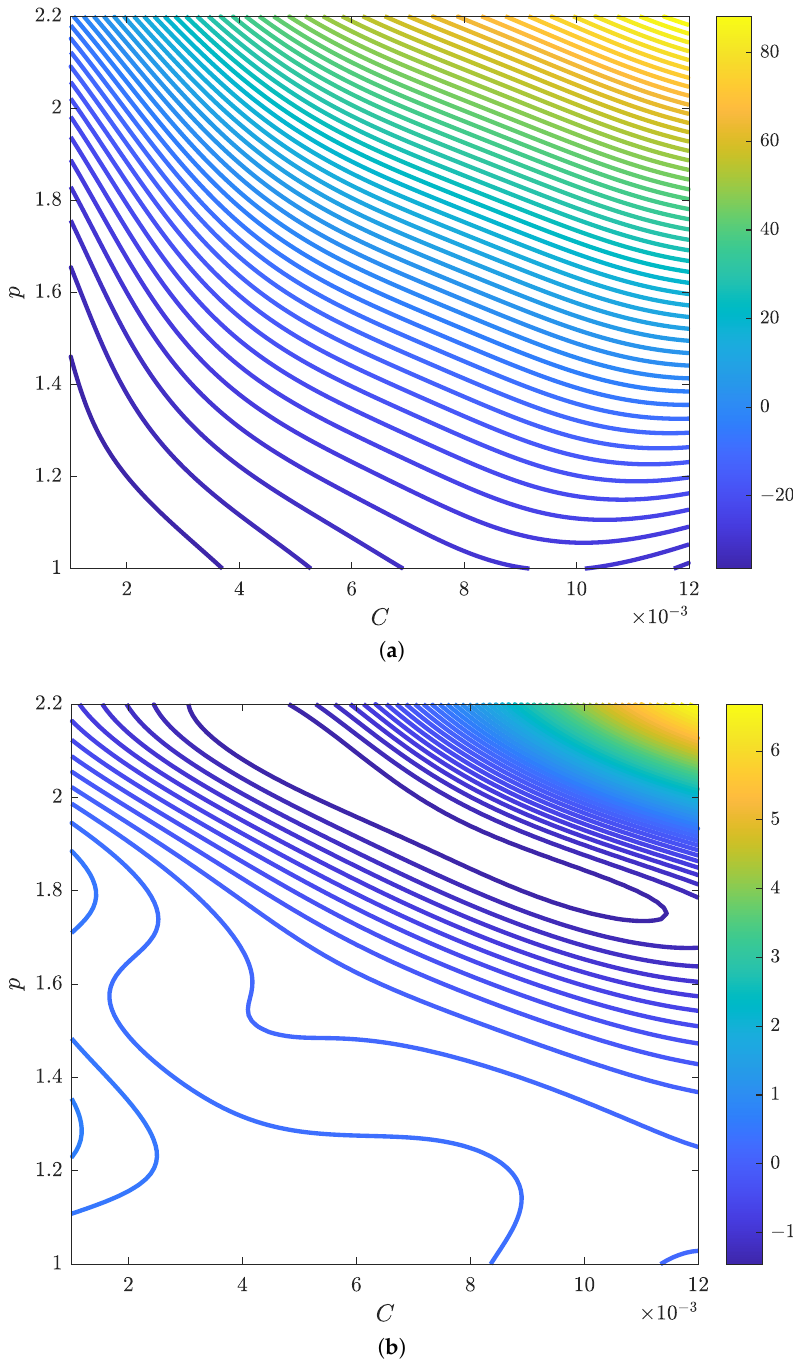
Figure 10. Contours of the first two basis coefficients estimated by the constructed Kriging models.